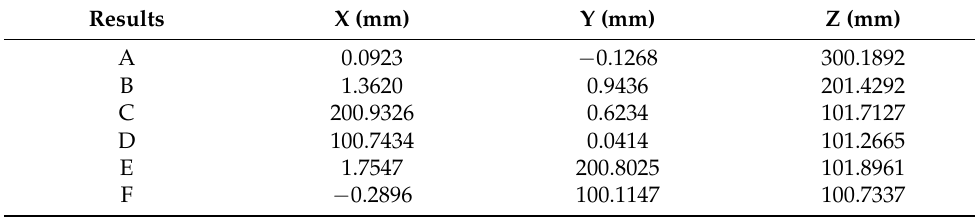
Table 5. Result of space point